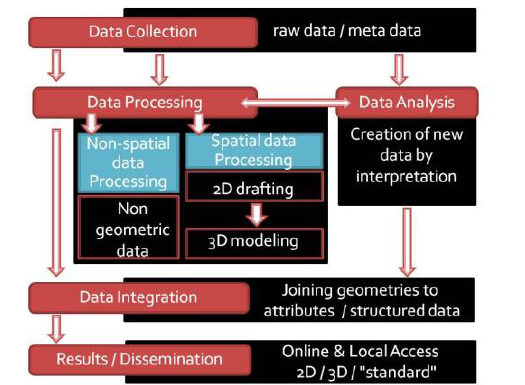
Figure 3. General workflow of the research.